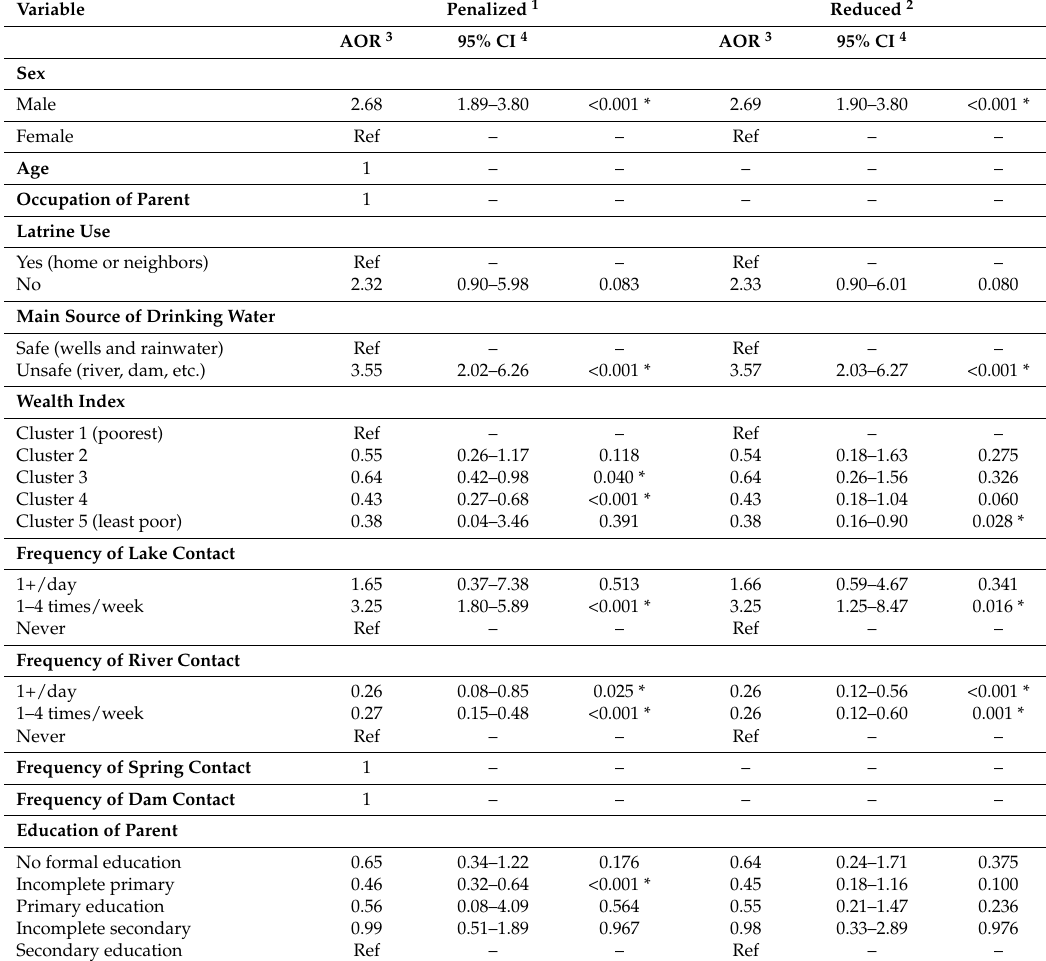
factors with nonzero coefficients in the LASSO regression. 3 AOR: adjusted odds ratio. 4 CI: confidence interval; * statistically significant finding ( p <